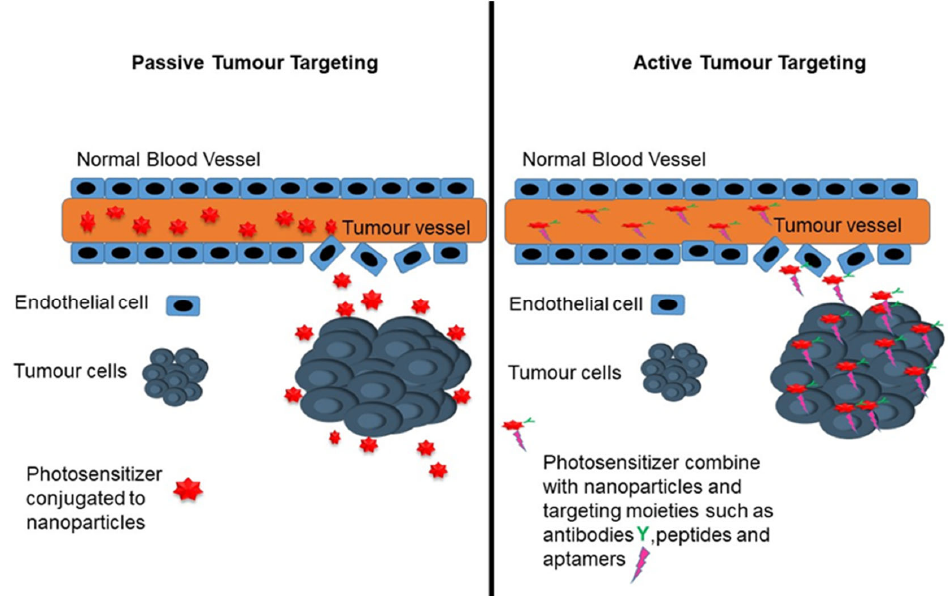
Figure 3: Schematic presentation of passive and active tumour